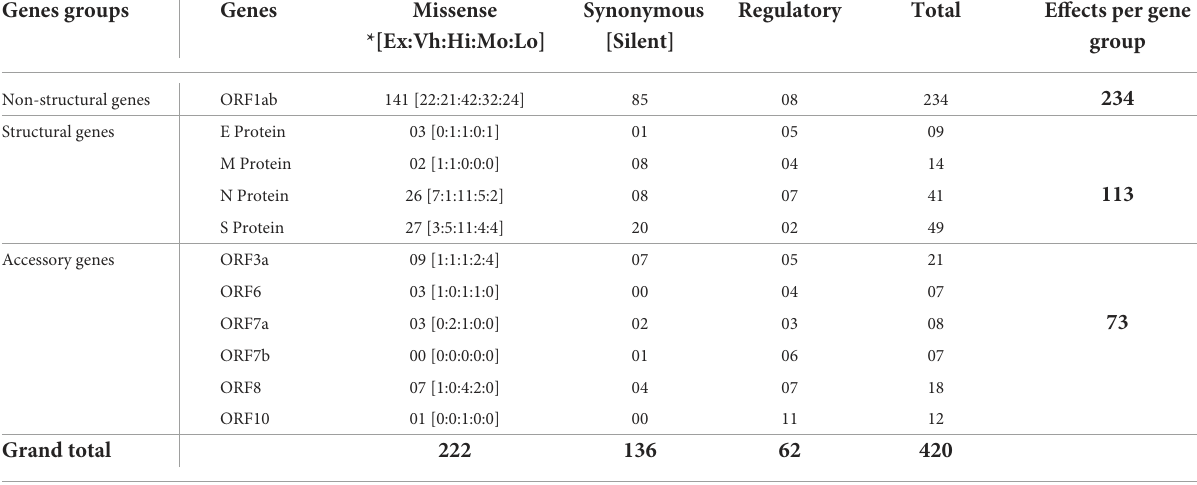
TABLE 3 Functional effects of all identified category-specific recurrent SNVs (CaSp-rcntEffs) count across all SARS-CoV-2 genes. Genes groups